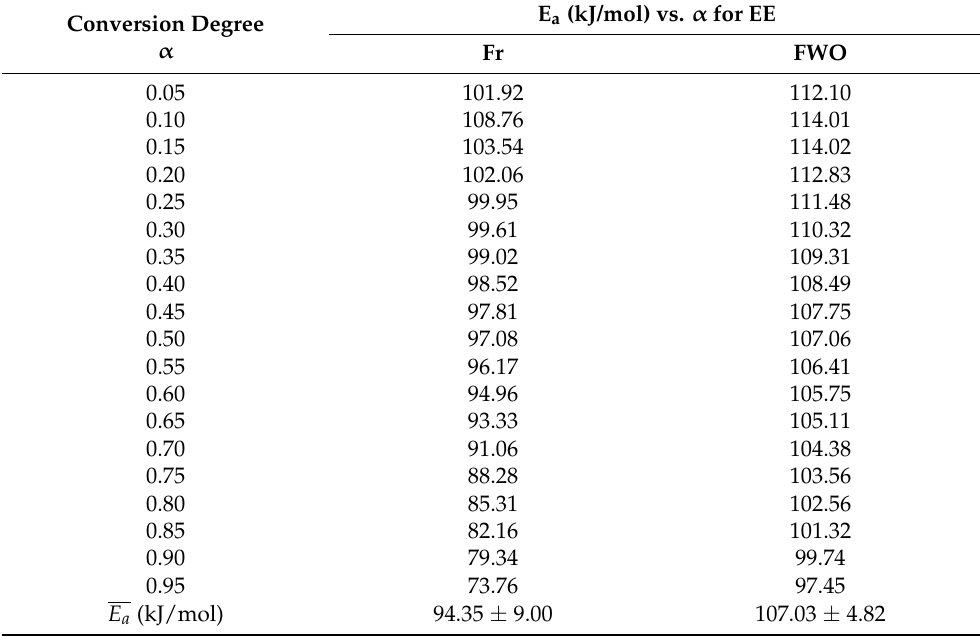
Table 1. Evaluation of the decomposition E a values vs. conversion degree obtained by the two isoconversional methods and the mean value of E a .